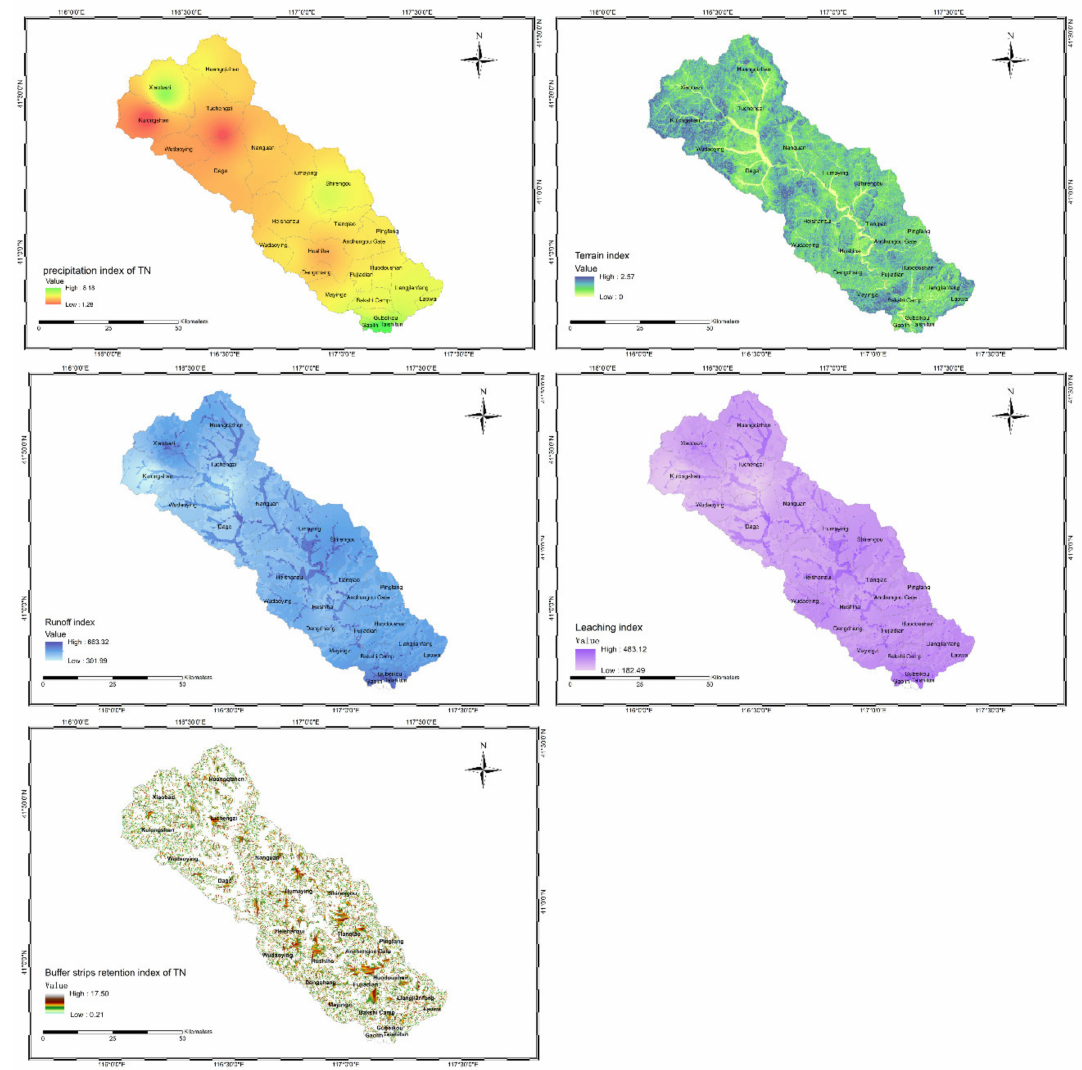
Figure 3. Spatial distribution of the five factors of NPS with respect to